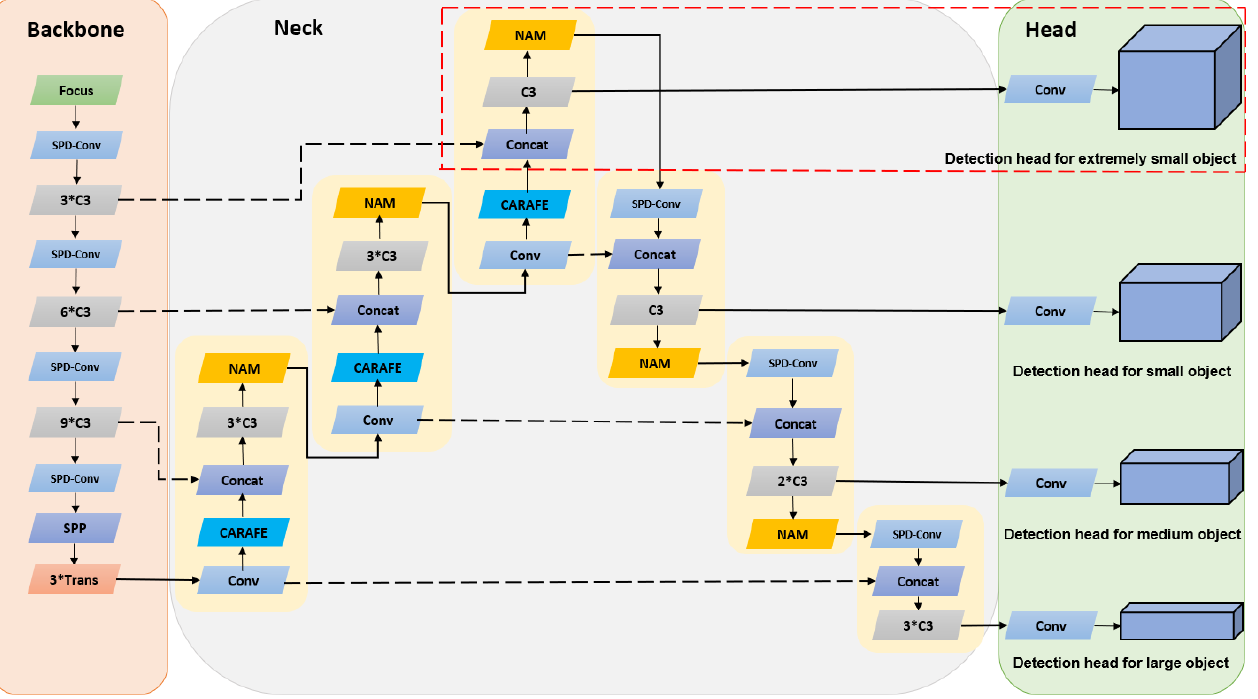
Figure 2. Overview of multi-scale YOLOv5s. It is better suited than the original YOLOv5s for the detection of small objects in complex traffic